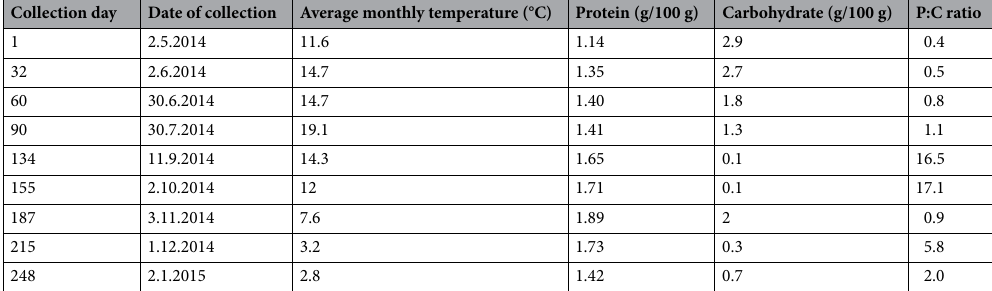
Table 1. Natural diet sample information: collection day (counted from the date of the first sample collected), date of sample collection, average temperature of the month the diets were collected, protein value, carbohydrate value and protein to carbohydrate ratio of each sample.